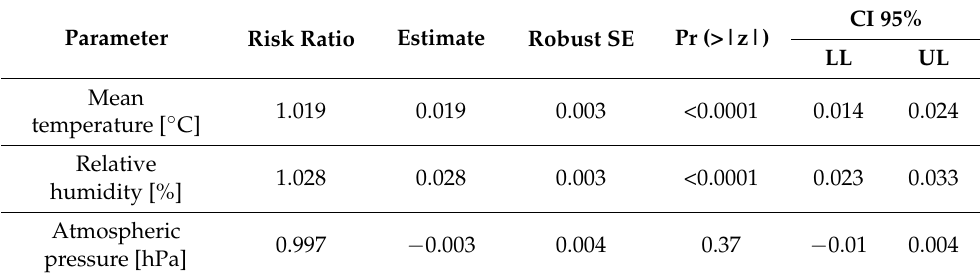
Table 5. Poisson regression model regarding the number of stroke cases in each season depending on weather conditions (AIC =